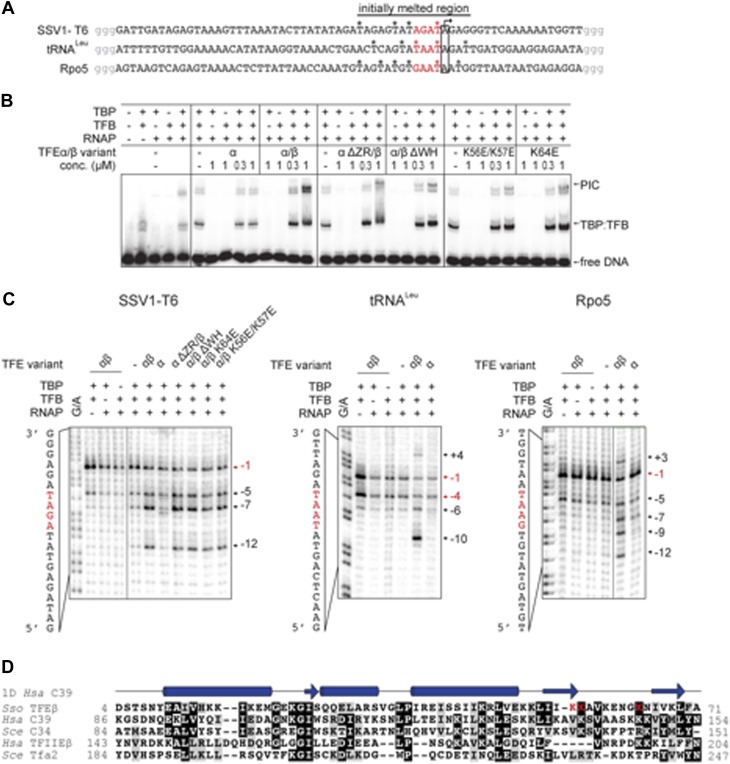
TFEα/β increases the stability of the preinitiation complex (PIC) and promotes DNA melting.(A) NTS sequence of the DNA templates for the promoters tested in electrophoretic mobility shift assay (EMSA) and potassium permanganate footprinting assays. The templates incude a 4 nt heteroduplex region (positions −4 to −1 relative to the TSS, in red) that was generated by introducing transition mutations into the template strand Asterisks mark permanganate-reactive T residues (see panel C). Additional G residues (in grey) were added to stabilize the termini. (B) PIC formation on the SSV1-T6 promoter in response to TFEα/β, TFEα and mutant variants using EMSAs. K56E/K57E and K64E denote mutations in the TFEβ WH. (C) The non-template strand of the SSV1-T6 and Sso Rpo5 and Sso tRNALeu promoters was probed in potassium permanganate footprinting assays. The position of reactive T residues is indicated on the right. G/A ladder and the DNA sequence are shown on the left. (D) Sequence alignment of the WH domains of TFEβ (gene id: 1455187), WH2 of human C39 (gene id: 10621), WH2 of yeast C34 (gene id: 855737), WH2 of human TFIIEβ (gene id: 2961), and WH2 of yeast Tfa2 (gene id: 853936). Identical and similar residues are shaded in black and grey, respectively. On top of the alignment the secondary structure of WH2 of human C39 (PDB id: 2DK5) is depicted (α-helices as barrels and β-strands as arrows). Residues K56, K57 and K64 in the WH domain of TFEβ where mutations were introduced are highlighted in red.